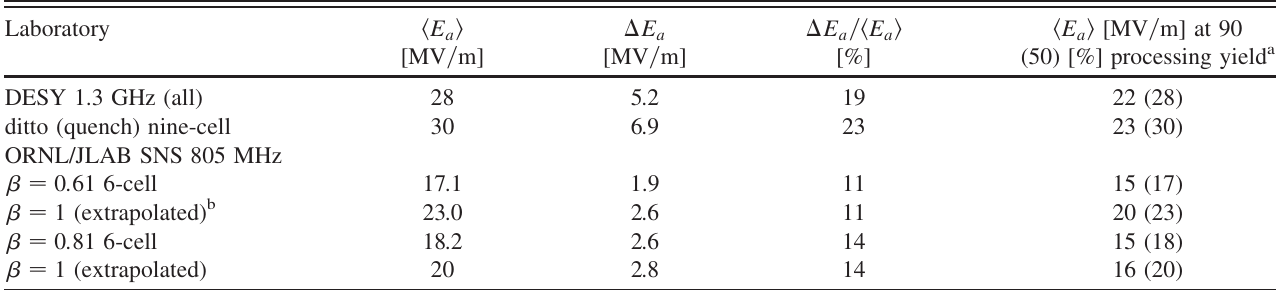
TABLE X. Summary of results in other